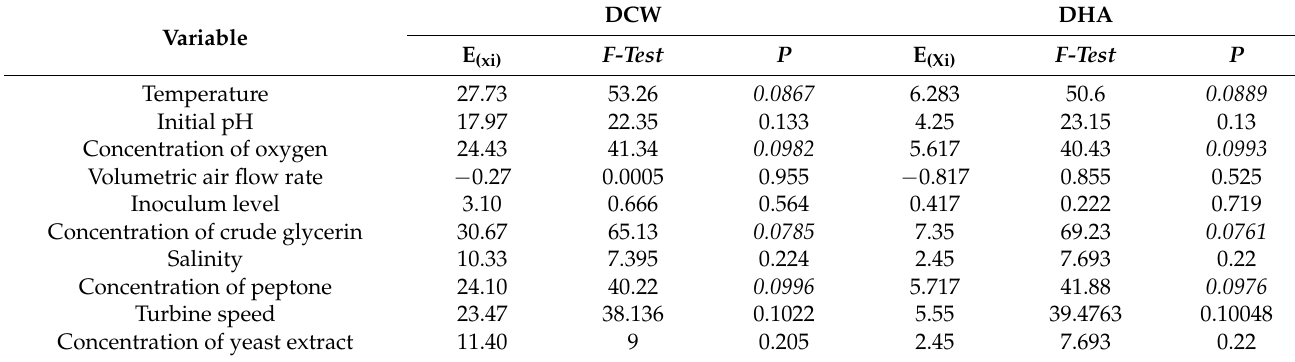
Table 8. Effect of variables on DCW and DHA concentrations, with related statistical test results.